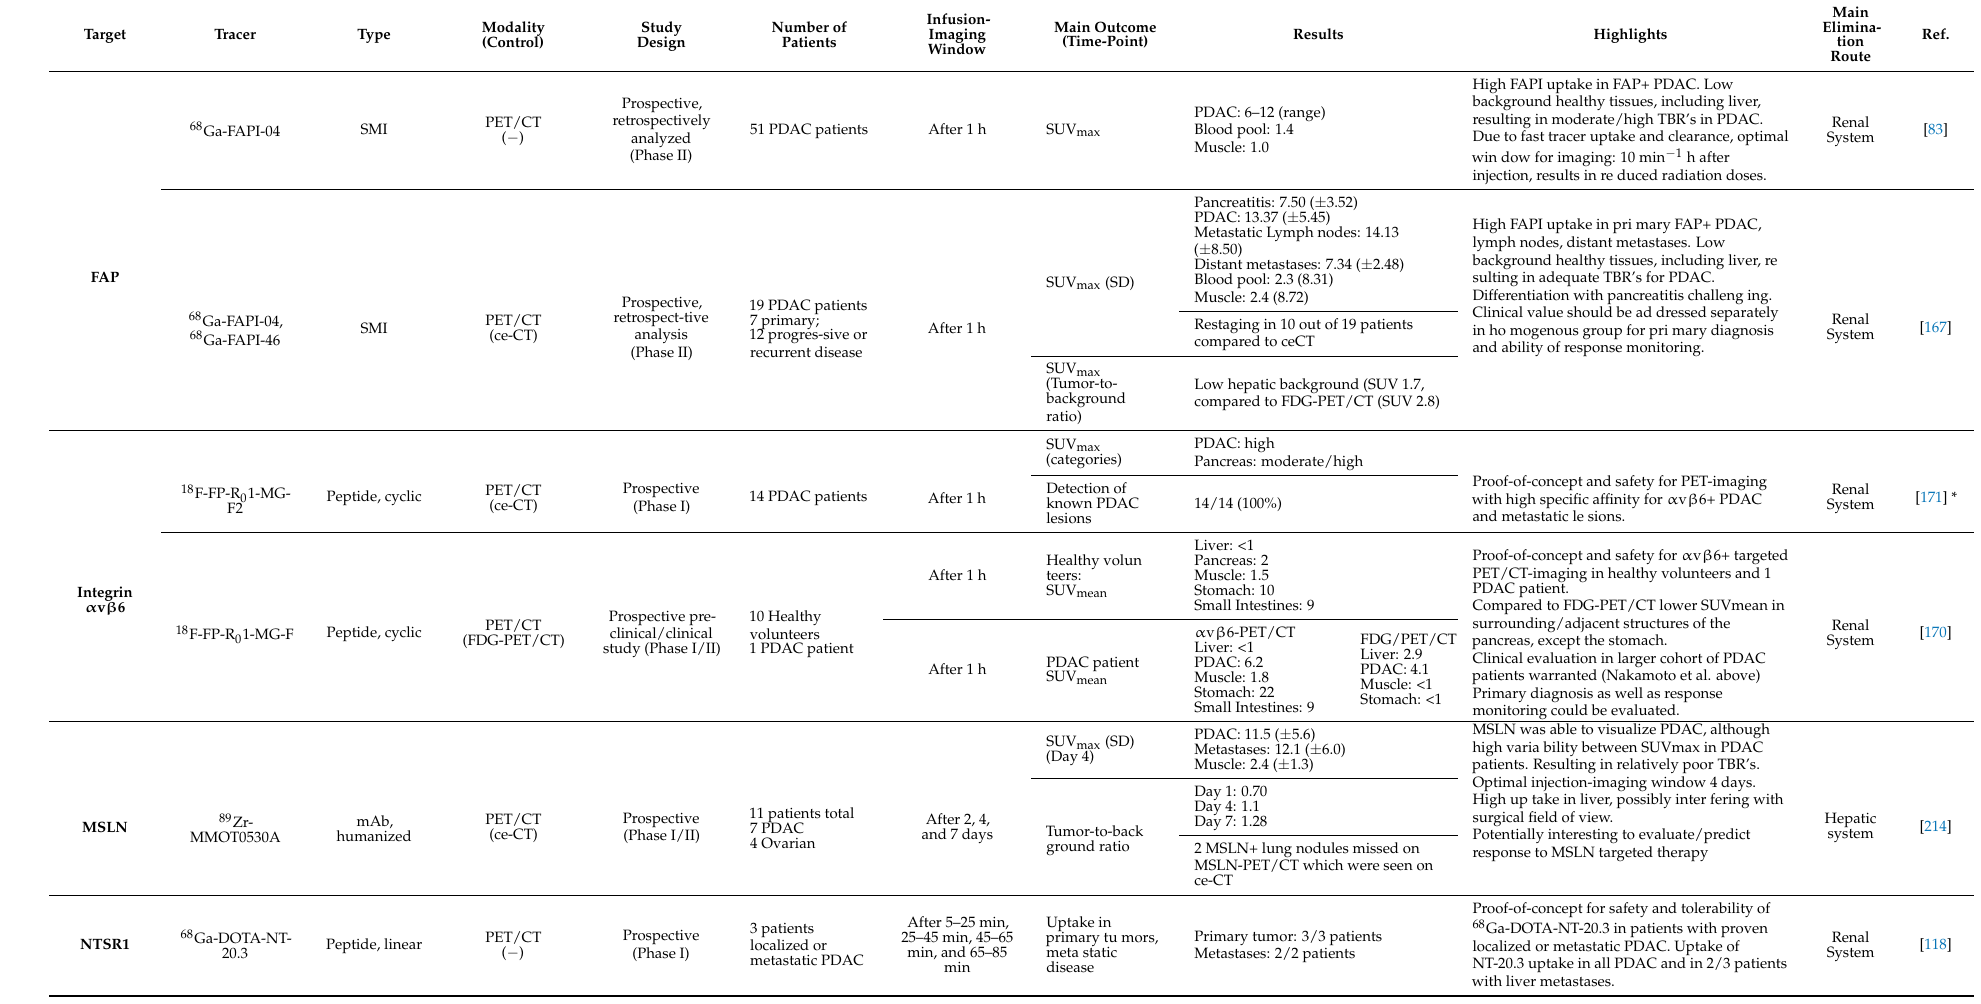
Primarytumor: 3/3patients Metastases: 2/2patients disease